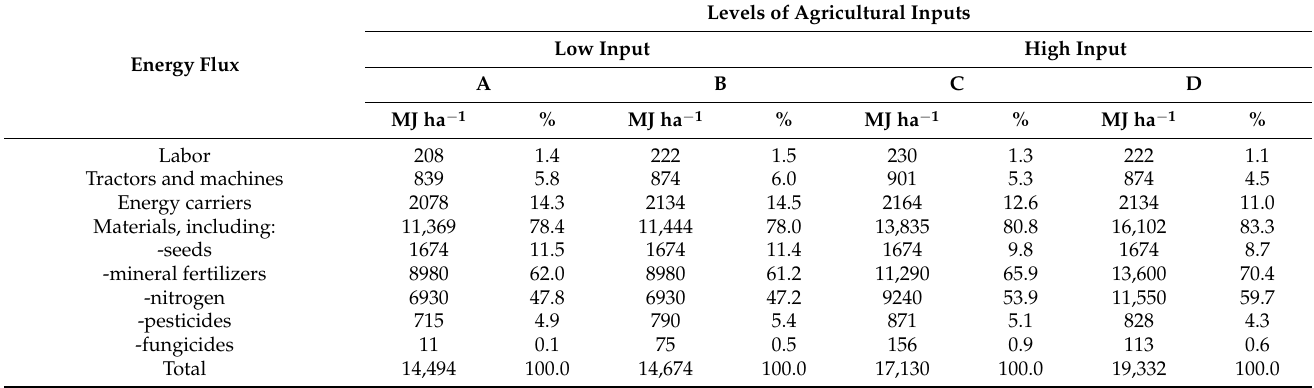
Table 5. Structure of energy inputs in the production of a semi-dwarf genotype of winter triticale by energy fluxes (2008–2011).